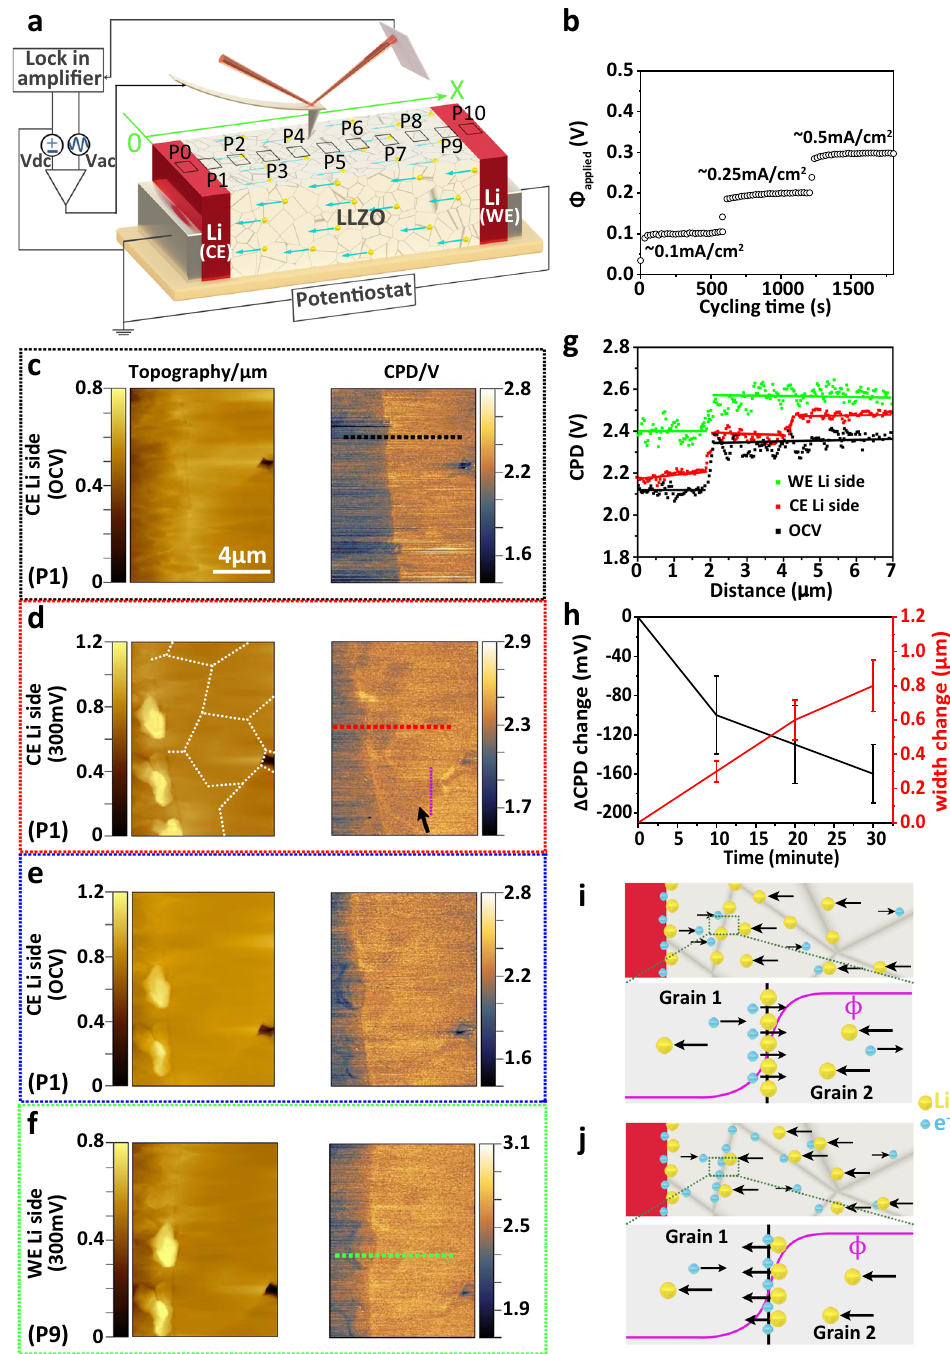
Δ CPD and width change as a function of time under 300mV for the region along Fig.1|OperandoKPFMmeasurementsonLLZOclosetoelectrode.a Schematic ofKPFMontheLLZOsurfaceofasymmetricLi|LLZO|Licell.Thecellwascycledviaa dotted purple line in CPD maps in d . The error bars correspond to statistics at potentiostat. b Cycling performance of the symmetric Li|LLZO|Li cell with poten- differentdatapointsalongdottedpurpleline. i , j aretwohypotheticalscenariosfor tials of 100, 200, and 300mV applied to the Li-WE at the set constant current the formation of a space charge layer at grain boundaries. Scenario i results from densitiesof0.1mA/cm 2 ,0.25mA/cm 2 ,and0.5mA/cm 2 . c – f Topographyimagesand different conduction properties of lithium ions. In this scenario, the Galvani thecorrespondingCPDmapsofOCVstate,lithiumplatingattheLi-CE,relaxedand potential would drop at all the grain boundaries across the whole LLZO pellet. re-equilibratedstate,andlithiumstrippingstateatLi-WEwithapotentialdifference Scenario j results from different conduction properties of electrons at grain of300mVbetweenthetwoelectrodes. g Linepro fi lesextractedfromCPDmapsin boundaries, c (dashed black line), d (dashed red line), and f (dashed green line). h Measured decomposition or a lithium reduction in those grains. In that case, drop of CPD indicates a drop of the Galvani potential, as evidenced by Δ CPD would persist after switching ϕ additional measurements on Li|LLZO|Au Hebb-Wagner cells (Supple- applied back to 0. On the other hand, a lower CPD of thoseparticular grains mayindicate a drop of the mentary Figs. 10 – 12 and Supplementary Note 3). In that case, Δ CPD local Galvani potential at grain boundaries to neighboring grains. The would be reversible and return to 0 after ϕ applied is switched back to 0.